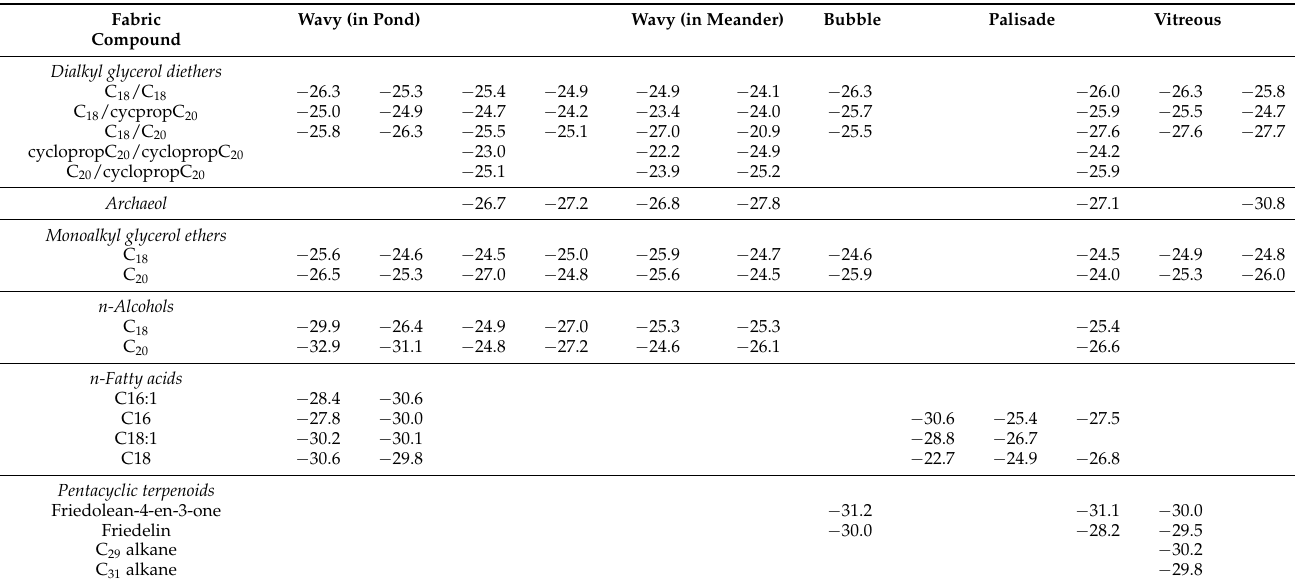
Table 2. δ 13 C isotopic values of biomarkers in samples from wavy laminated (pond margin and meander), vitreous, palisade, and bubble